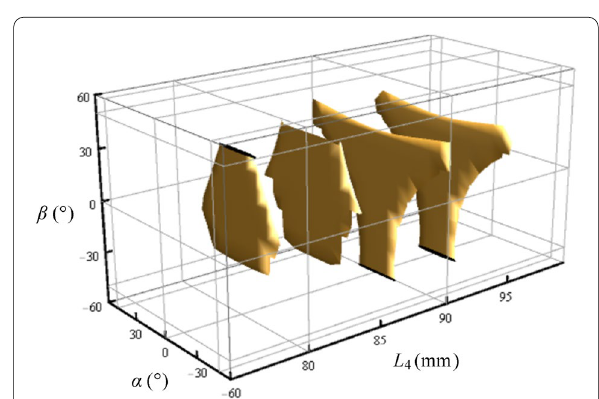
Figure 13 L 4 80–95 mm workspace images of the mechanism =